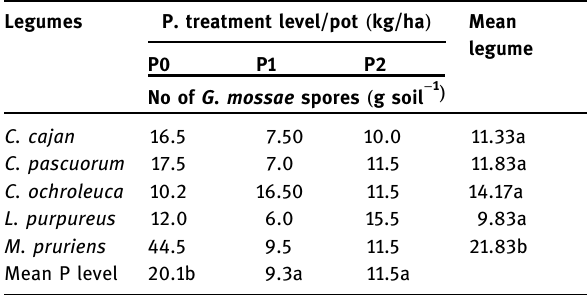
Table 2: E ff ect of phosphorus levels and studied legume species on total AM spores Legumes